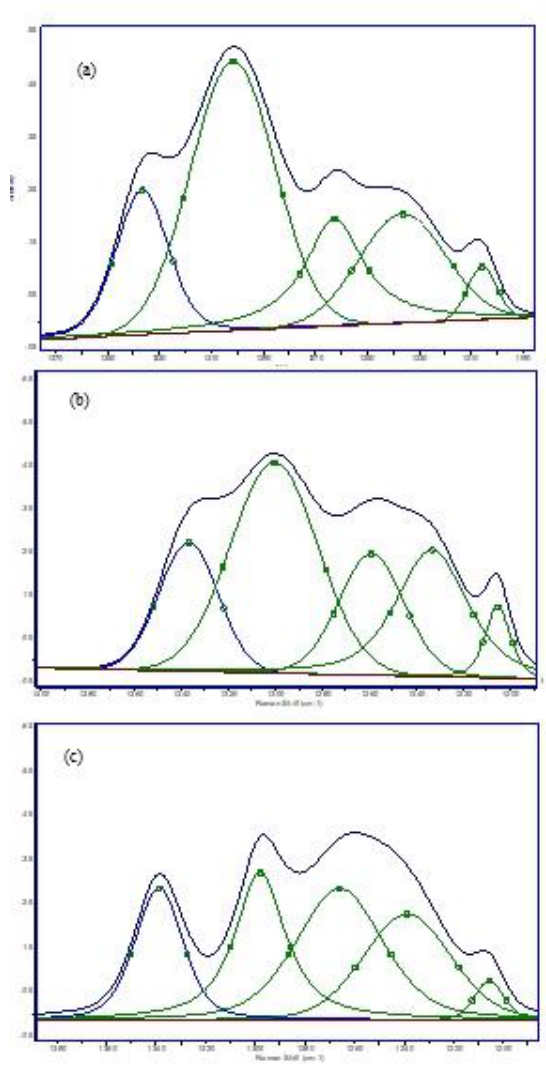
Figure 6. Peak fitting of 1190-1385 cm −1 region corresponding to ( a ) untreated Caco-2 cells and ( b ) Caco-2 cells incubated for 24 h with 72 h UV-radiated fish oil (100 μg/mL) and ( c ) ML (100 μg/mL).